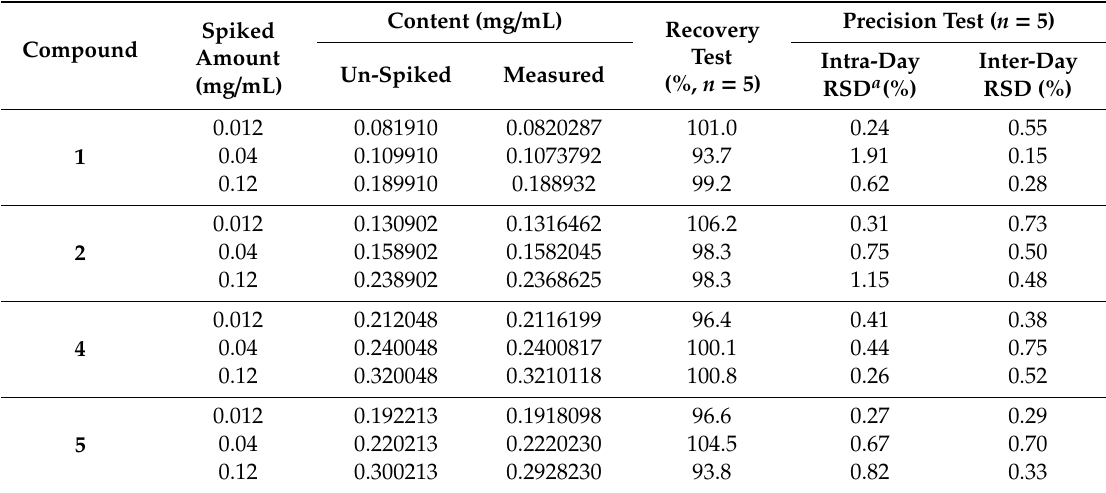
Table 3. Accuracy, intra- and interday precision of the standard compounds in